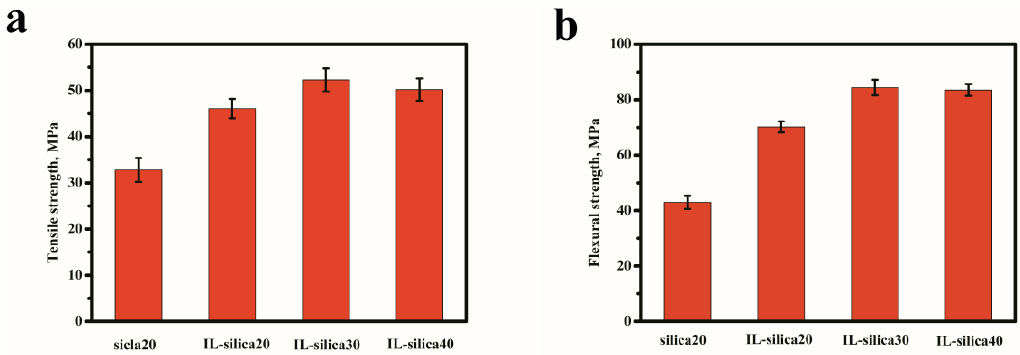
Figure 5. Cont. Figure 5. Cont